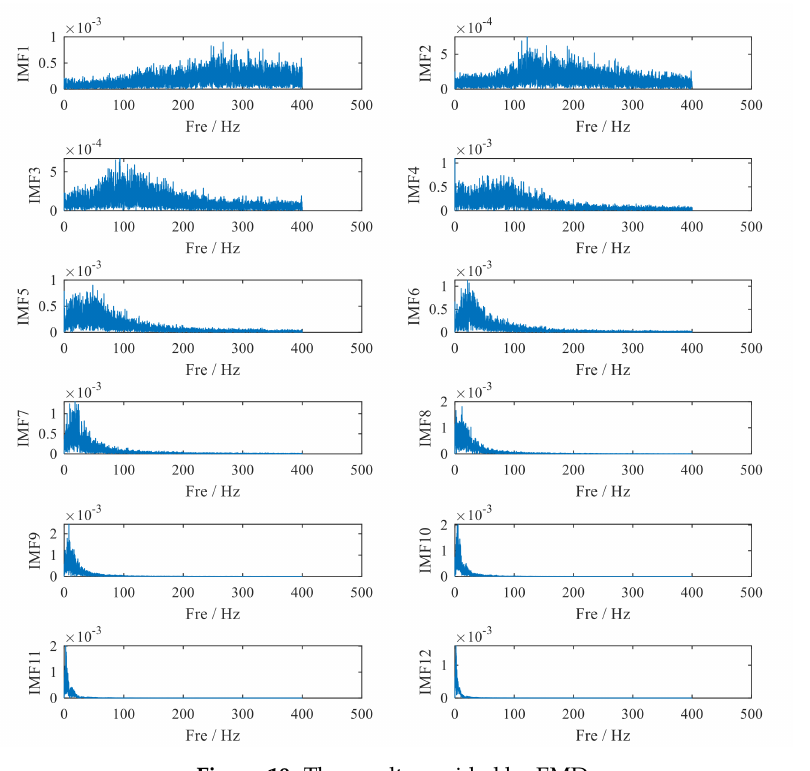
Figure 19. The result provided by EMD.